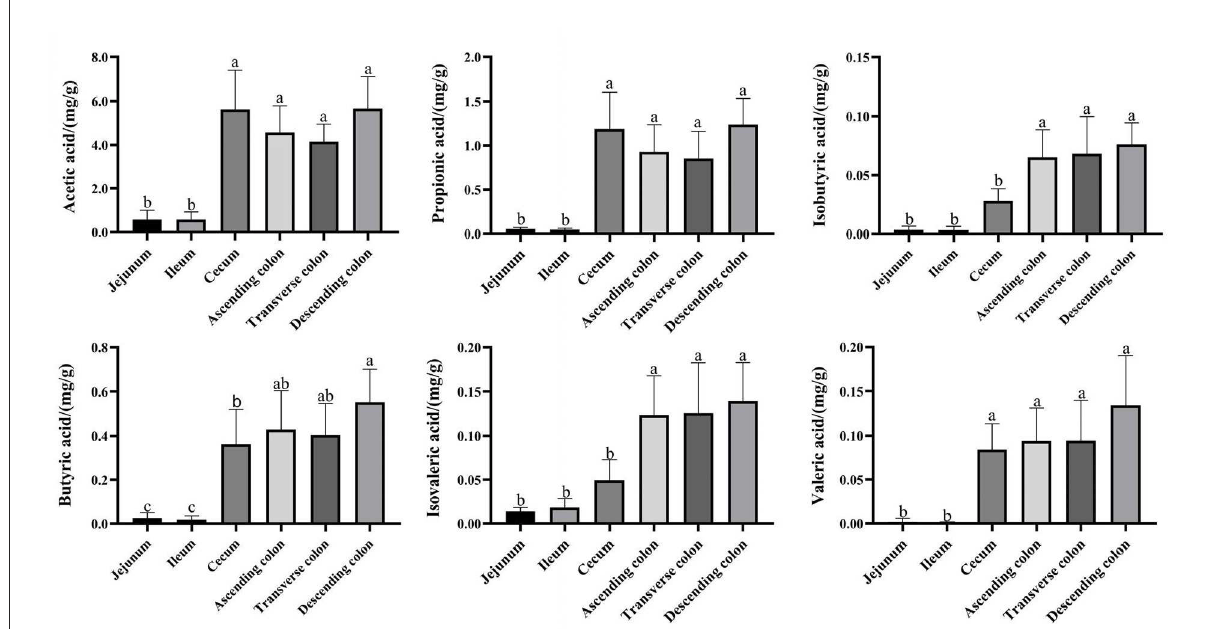
FIGURE5 Concentrations of SCFA in different intestinal locations of pigs. Data are shown as mean ± SD ( n = 6). The same letter within each column indicates no significant difference ( p > 0.05).